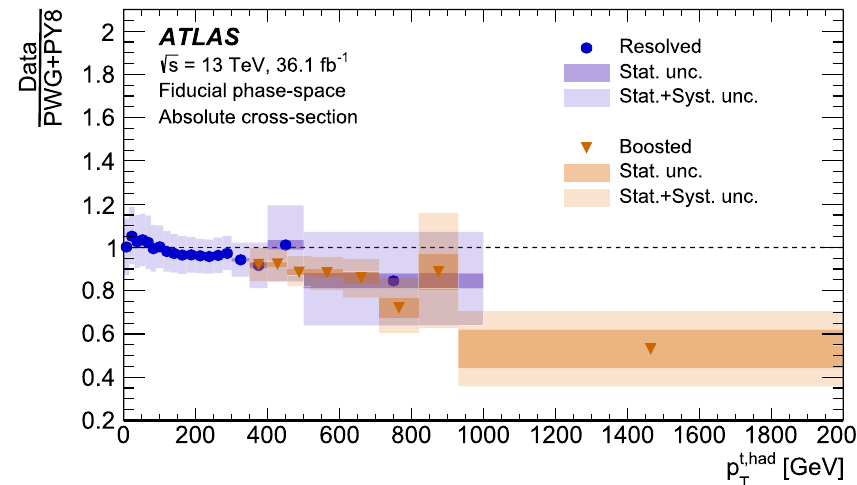
Fig. 54 The ratios of the measured fiducial phase-space abso- lute differential cross-sections to the predictions obtained with the Powheg + Pythia8 MC generator in the resolved and boosted topolo-